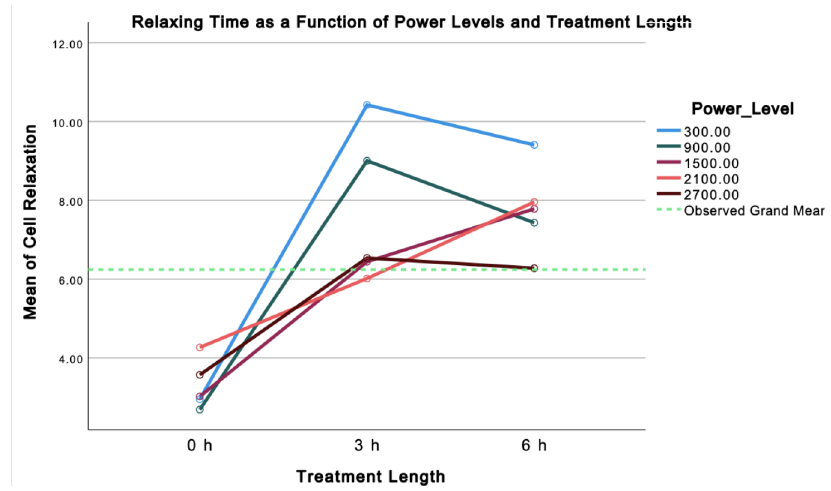
Figure 8. Relaxation time constant as a function of the treatment length at various